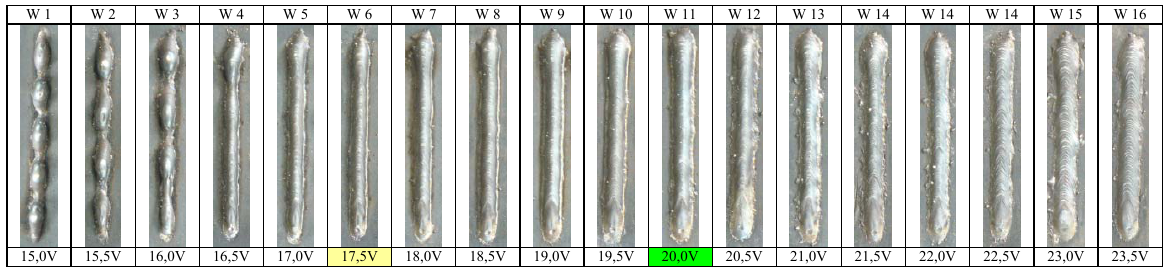
Figure 5. Weld Run Experiments.